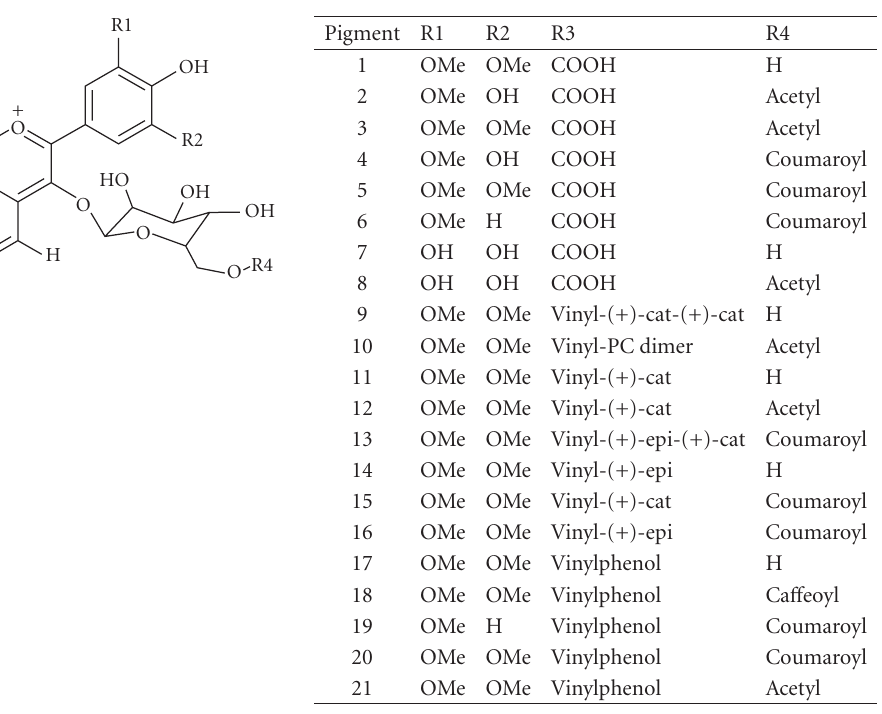
Figure 2. Pyranoanthocyanin structures detected in wine fractions (Table 1); cat = catechin; epi = epicatechin.